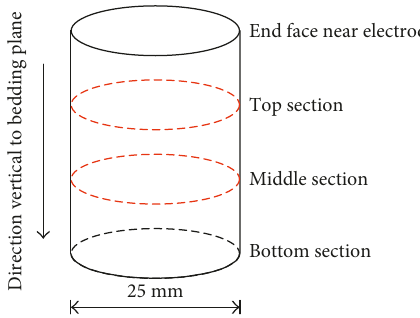
Figure 3: Schematic diagram of trisection along the direction vertical to the bedding plane of